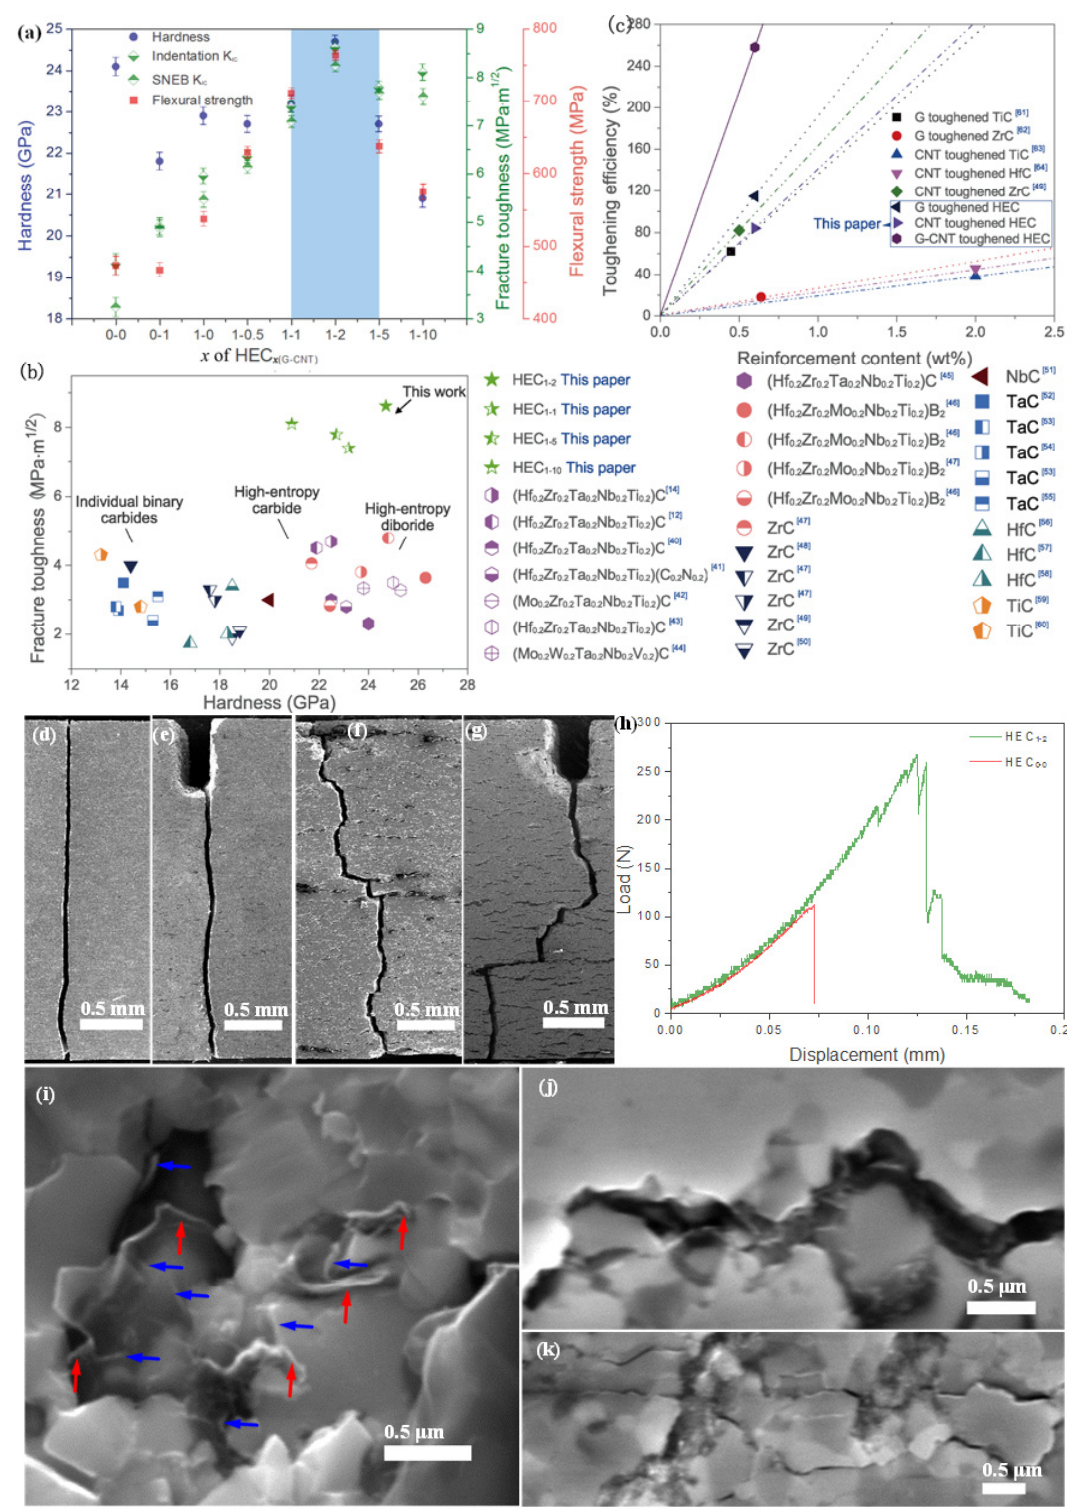
Fig. 4 (a) Principal mechanical properties of baseline HEC and nanocomposite samples, (b) Ashby plot of toughness vs. hardness of the investigated HEC in comparison with those of other HEC and individual binary carbides [12,14,40–60], (c) toughening efficiency of G–CNT, single G, and single CNT [30,61–64], corresponding fracture surfaces of (d, e) HEC 0-0 and (f, g) HEC 1-2 after three-point bending tests and SENB tests, (h) load–displacement curves of HEC 0-0 and HEC 1-2 on SENB samples, (i) fracture surface of HEC 1-2 , and (j, k) VI cracks of HEC 1-2